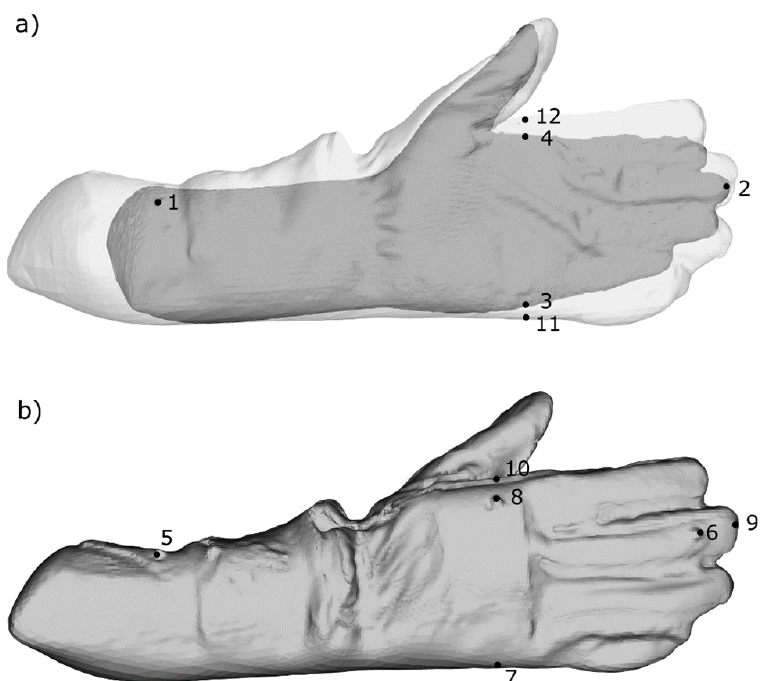
Figure 3. Landmarks reference points for dimensional allowances calculation: ( a ) the bare hand with the landmarks used for determining its dimensions (linear dimensioning) and superimposed clouds of the bare and gloved hand for circumference dimensioning; ( b ) the glove with the placed landmarks used to define the dimensions of the glove and the position of the hand therein (linear dimensioning). For the calculation of t circumference dimensional allowances in the CloudCompare software, firstly the points clouds of the bare hand and hand in the protective glove were generated and superimposed. With the use of the Cross Section tool, a 1 mm hight mea- suring box was set at the appropriate level (see Table 1), to export new entities containing circumferences envelopes. The generated cross-sections were compared with the use of the Compute cloud/Cloud distance tool, providing us the information about the minimum, mean and maximum distances between bare and gloved hands. The description of the manual and 3D scan measurements performed within men- tioned stages is presented in Table 1. It contains the way of measuring anthropometric hand variables with the use of landmarks (reference points) for bare hand and hand in glove dimensioning has been presented in Figure